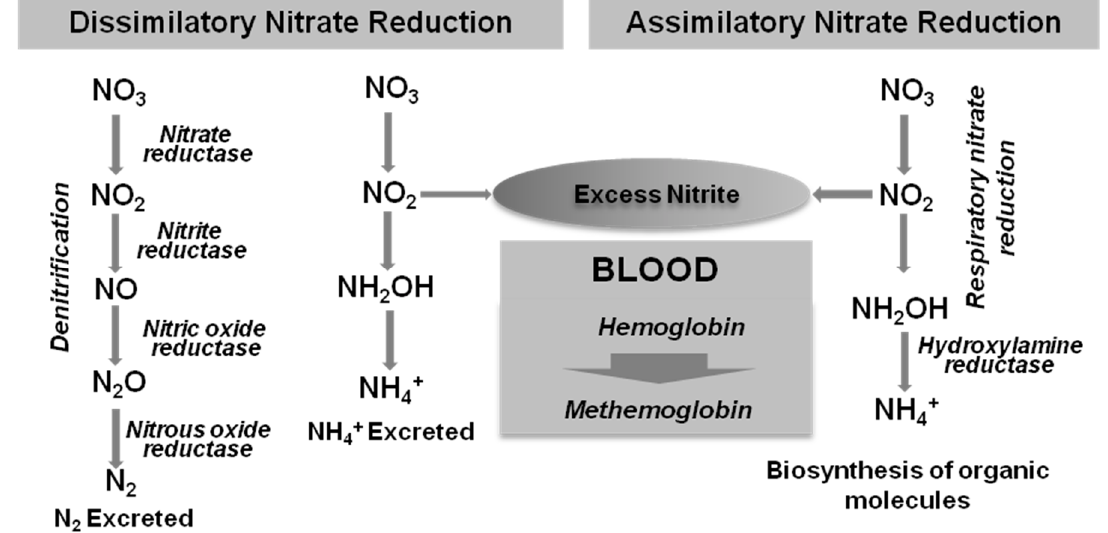
Figure 4. Assimilatory and dissimilatory routes of nitrate reduction.